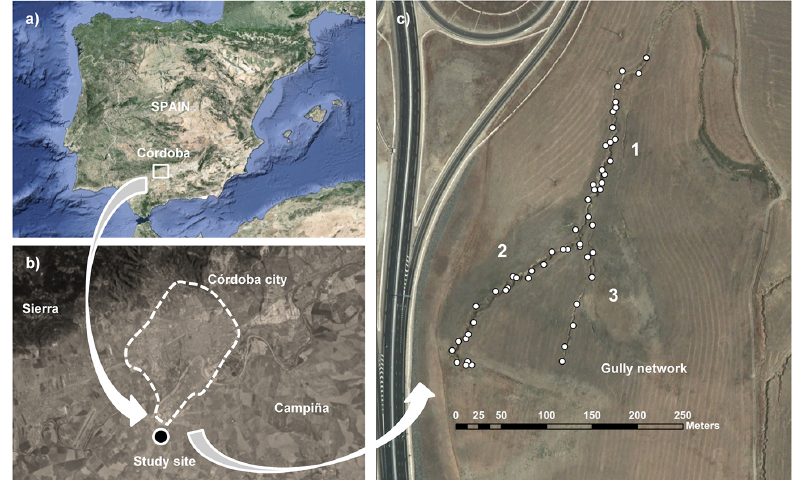
Figure 2. (a and b) Location of the study site (source: https://www.google.es/maps); (c) plan view of the gully network with indication of the branch number for photo-reconstruction purposes from the 2011 orthophotography (Junta de Andalucía, 2015). In white dots, the location of the ground control points GCPs deployed in the